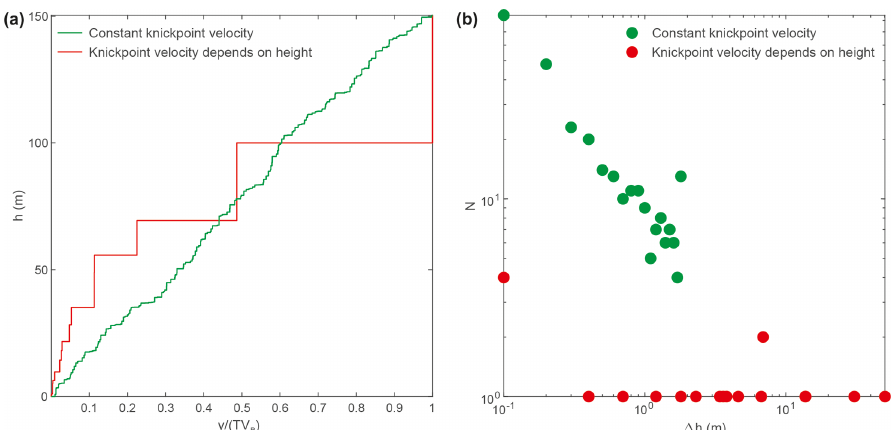
Figure 7. Modelled (a) river profiles and (b) knickpoint height distribution considering a constant knickpoint velocity (green line and circles) or a velocity depending on knickpoint height (red line and